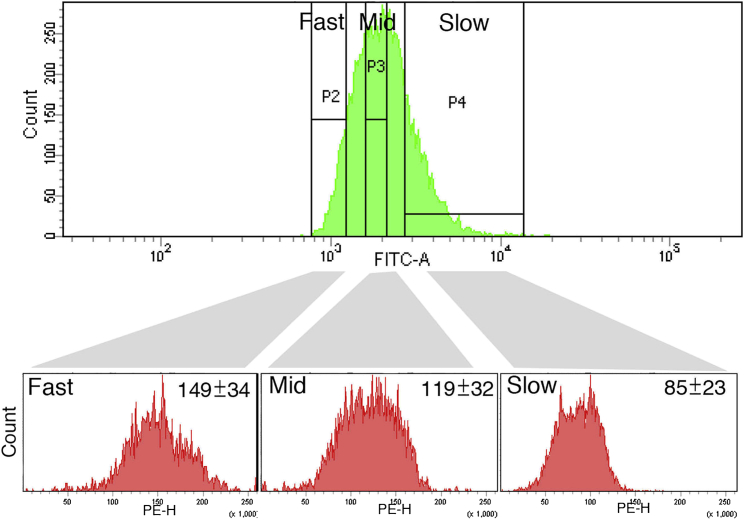
Telomere Shortening Accompanies Cell-Cycle ElongationESCs labeled with CFSE dye followed by culture for 48 hr were sorted by FACS into three groups according to the dilution of the dye, which gives cohorts of fast, medium, or slow cell cycles (upper panel). The telomere length of each cohort was measured by flow-FISH using a Cy3-conjugated telomere probe (lower panels). The average telomere intensity (×1,000) per cell ±SD is indicated. n > 5,000 cells. Two technical replicates showed the same tendency. Telomeres were shorter in the cells with longer cell cycles. See also Figure S6A.